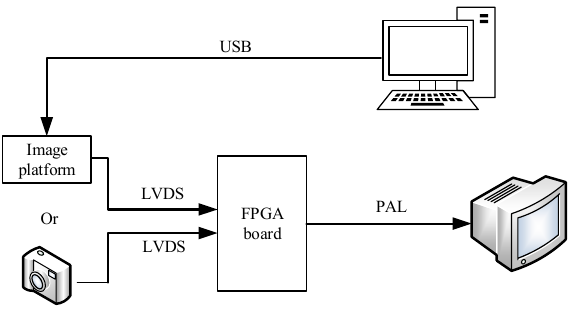
Figure 8. Field-programmable gate array (FPGA) hardware processing system.